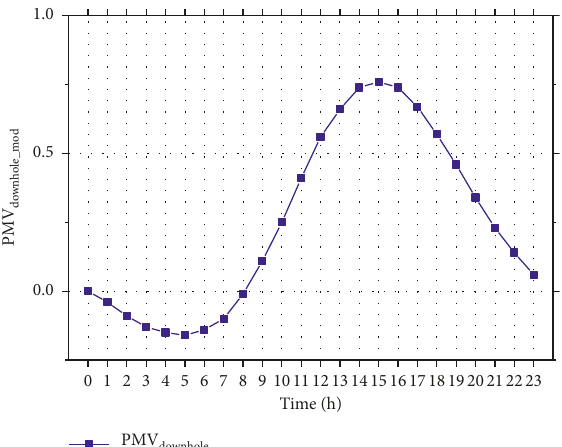
Figure 5: Downhole thermal comfort based on dynamic regula- tion. Note: PMV uphole_pre refers to the predicted thermal comfort values in the well; PMV downhole_mod refers to the modified downhole thermal comfort values; and PMV refers to the difference between the conditions in the well and the downhole thermal